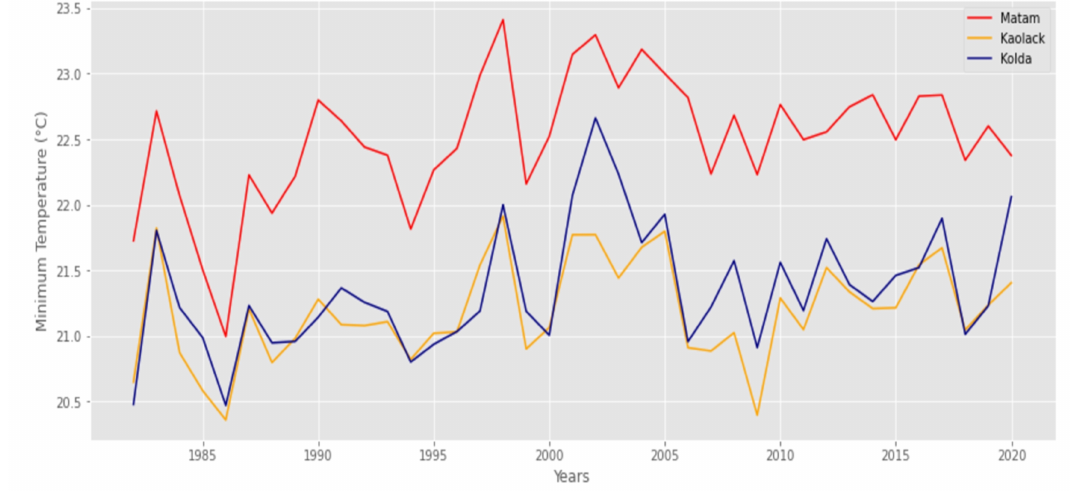
Figure 5. Annual average Minimum Temperature for Matam, Kaolack and Kolda (1982–2020).